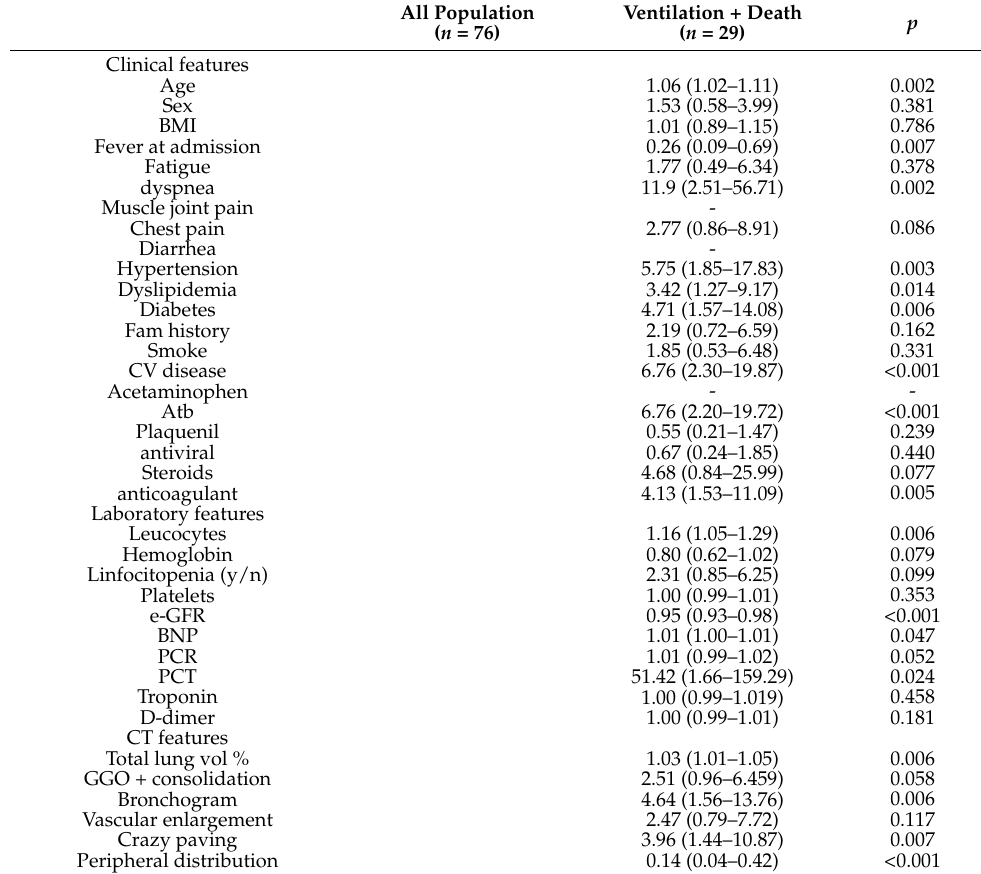
Table 2. Logistic regression analysis for clinical, laboratory, therapeutic and CT features for predictors of ventilation and